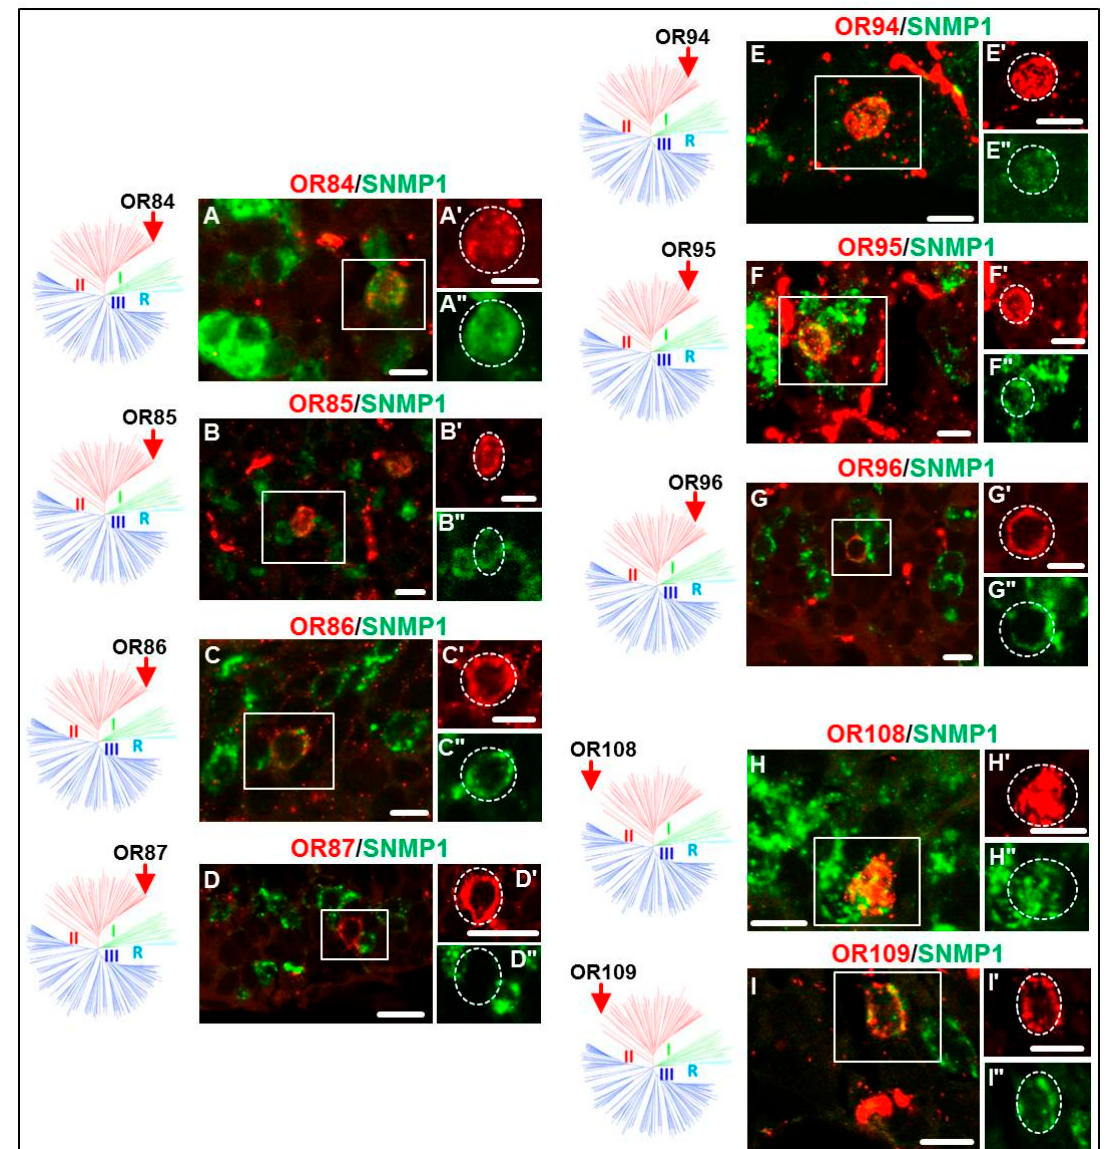
Figure 2. Expression of SNMP1 and group II SgreORs with paralogous sequences. ( A–I ) Expression of SNMP1 and SgreOR types of the three clusters/pairs comprising paralogues (SgreOR84-87, SgreOR94-96 and SgreOR108-109) was visualized by two-color FISH on antennal sections using specific antisense riboprobes for SgreORs (red fluorescence) and SNMP1 (green fluorescence). ( A’–I’, A”–I’ ’) Higher magnifications of single fluorescence channel images depicting the regions indicated by the white squares in A to I. The broken lines highlight the position of cells that express the defined OR types. With the exception of SgreOR87, all analyzed SgreORs are co-expressed with SNMP1. Scale bars, 10 µ m. On the left side of the images from FISH experiments, red arrows in the schematic representations of the phylogenetic tree indicate the position of the relevant SgreORs.